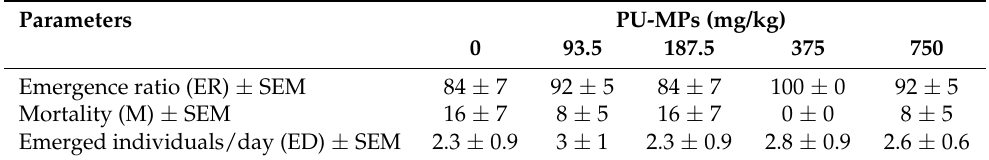
Figure 1. Effect of different concentrations of polyurethane microplastics (PU-MPs) on Chironomus riparius larval body length (n = 5). All values are presented as mean ± standard error of the mean. No significant differences between treatments were denoted. Table 2. Effect of different concentrations of polyurethane microplastics (PU-MPs) on Chironomus riparius life cycle endpoints. Emergence ratio (ER)-% of emerged individuals at the end of the experiment; Mortality rate (M)-% of dead individuals at the end of the experiment; and average % of emerged individuals per day (ED). All values are presented as mean ± standard error of the mean. No significant differences between treatments were denoted.